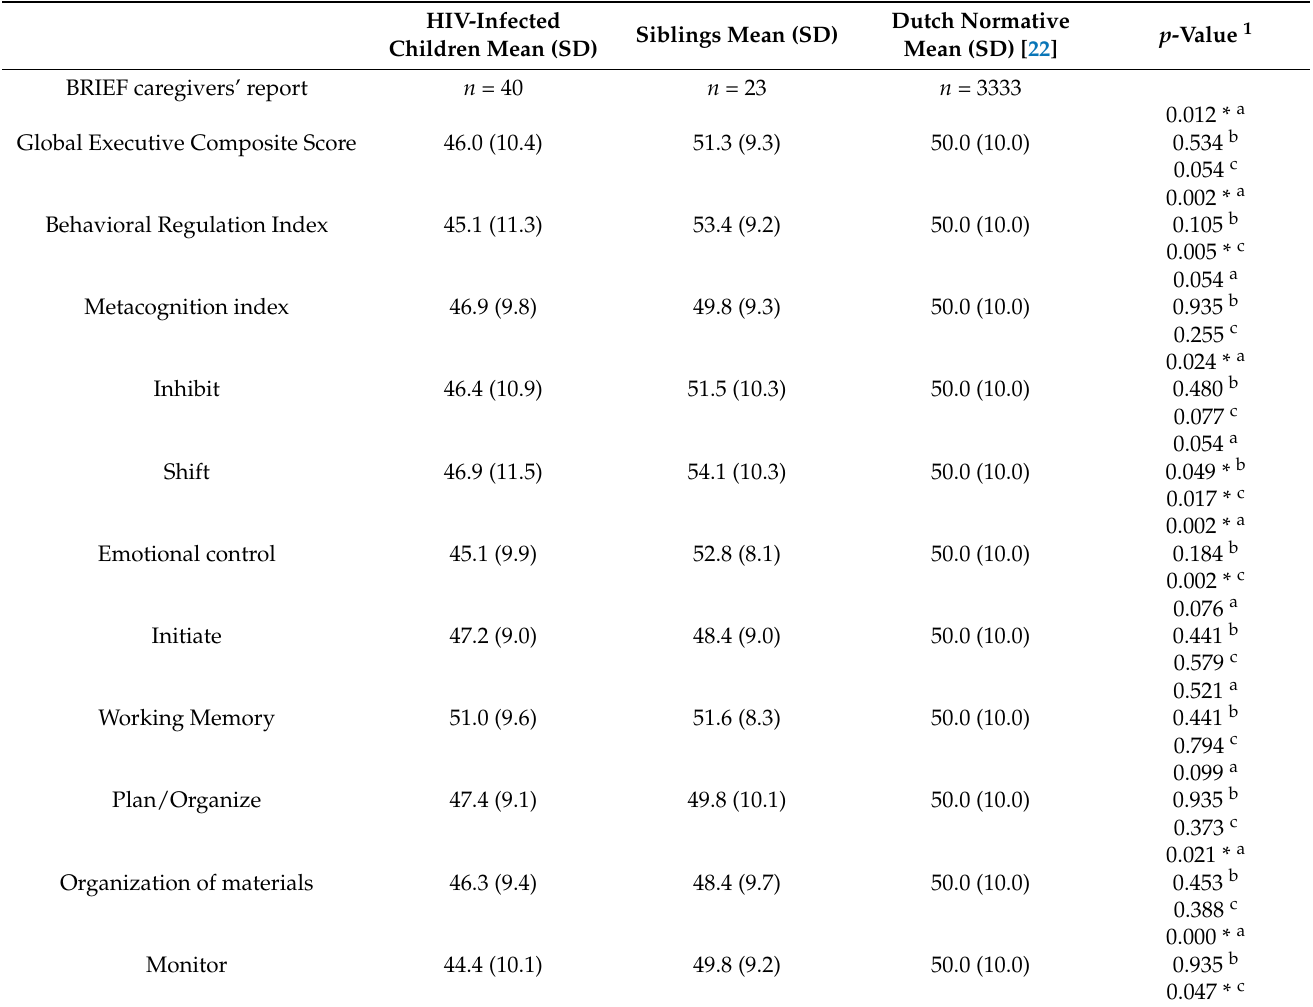
Table 2. Results BRIEF caregivers’